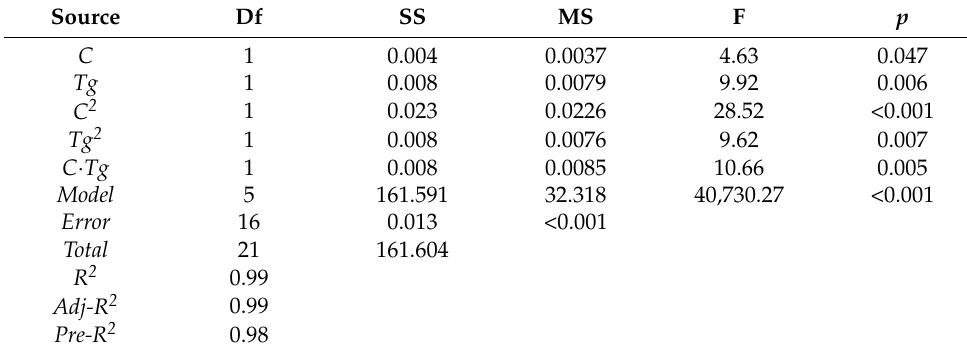
Table 2. Results of the variance evaluation.